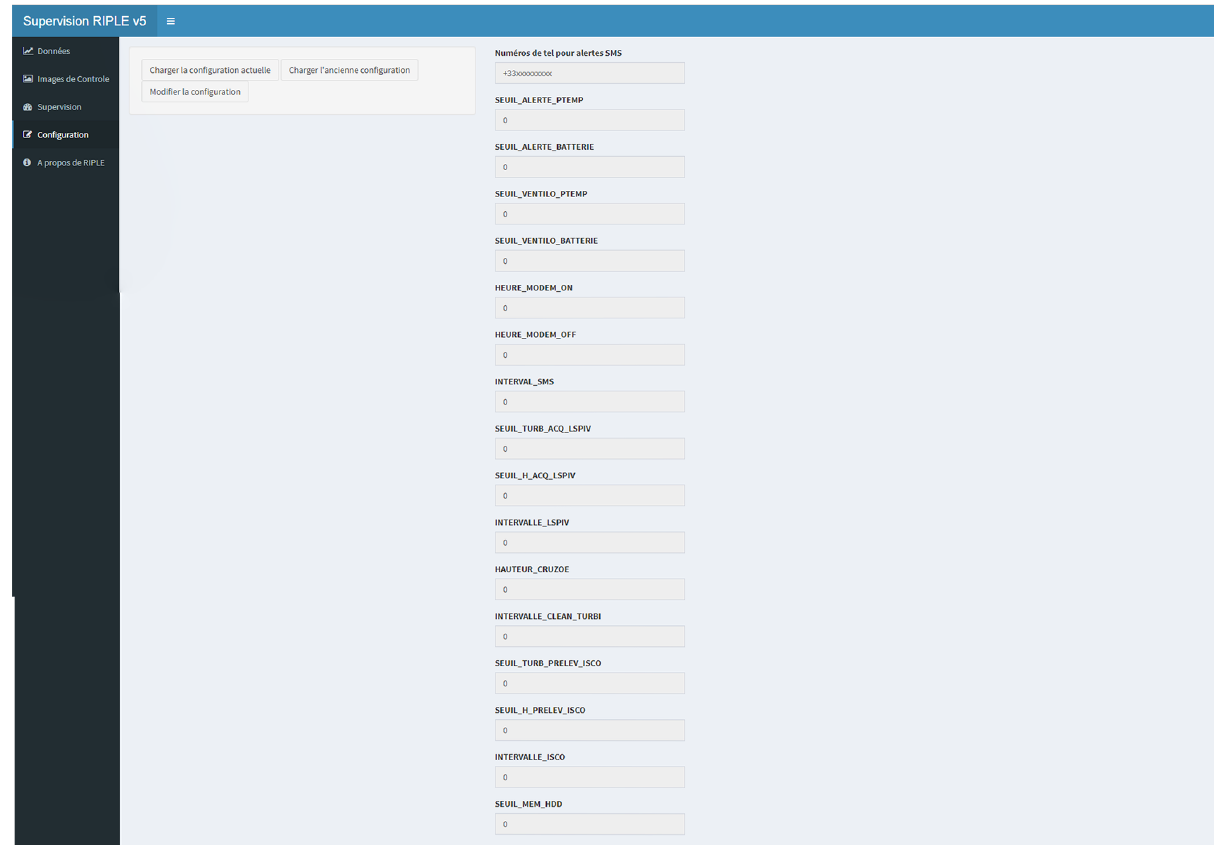
Figure 12. Screenshots of the “Configuration” menu of the user interface. All the external variables of the program that